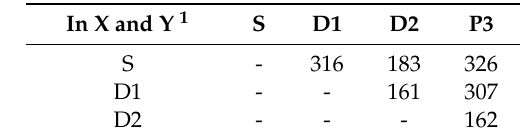
Table 3. Number of shared derived polymorphisms in the sequenced duplicated region between locus X, rows, and Y,